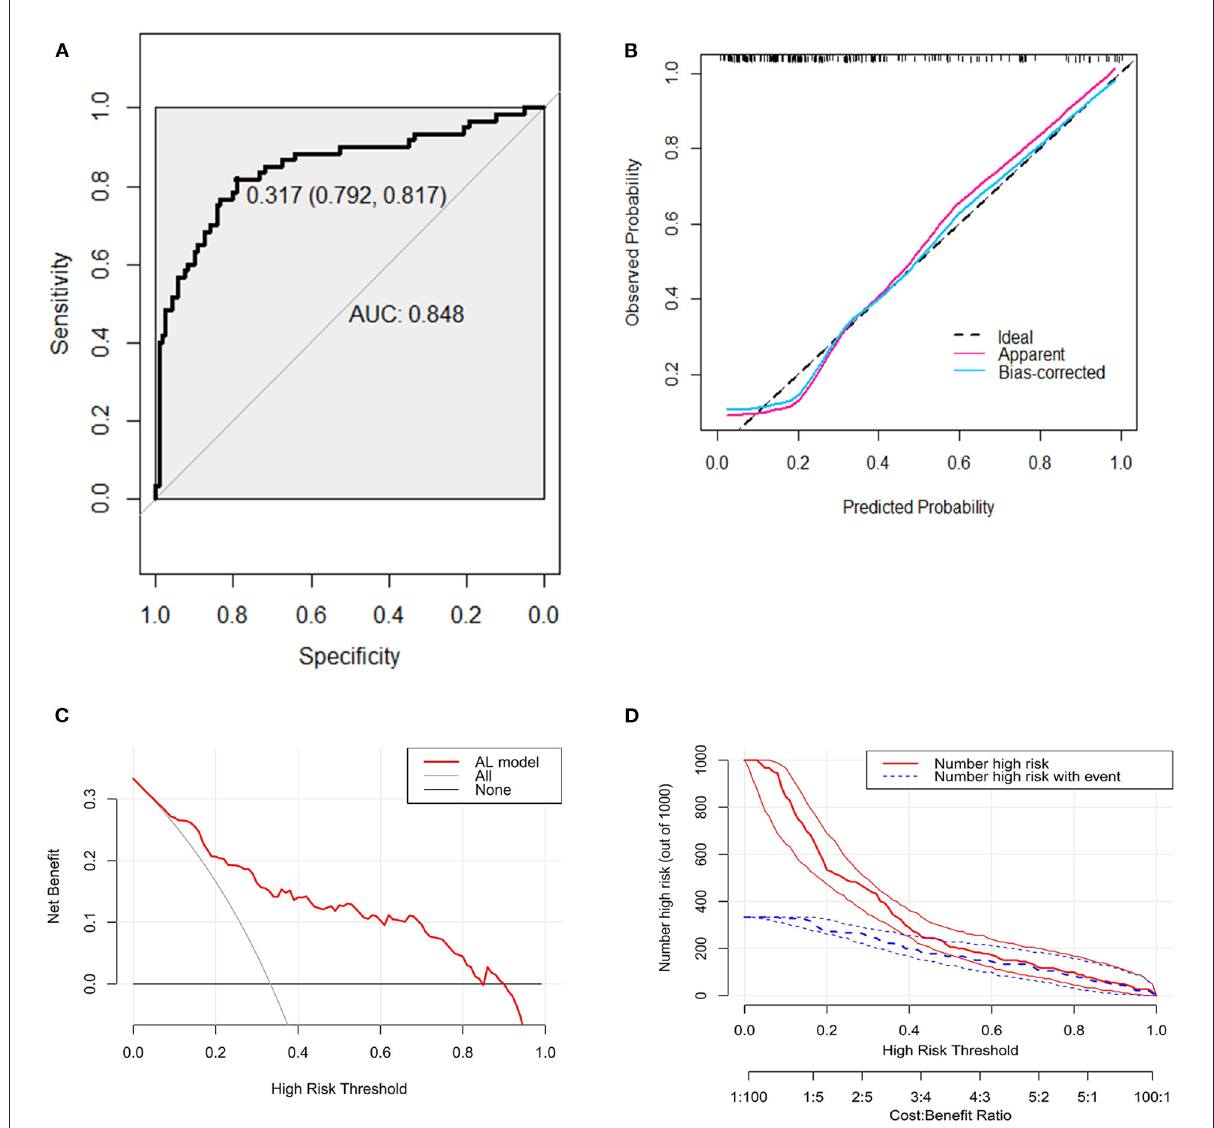
FIGURE3 Receiver operating characteristic curve, calibration curve, decision curve analysis (DCA), and clinical impact curve for predicting anastomotic leakage (AL) in patients with colorectal cancer (CRC). (A) Area under the curve for predicting the AL of patients with CRC. (B) Calibration plot of the prediction model (bootstrap method, 1,000 repetitions). (C) Decision curve analysis of the model for predicting the risk of AL for patients with CRC. The x-axis means the threshold probability and the y-axis means the net benefit. The black line assumes that no patient has AL. The gray line assumes that all patient has AL. (D) Clinical impact curve. The red curve (Number high risk) represents the number of people classified as positive (high risk) by the model at each threshold probability; the blue curve (Number high risk with event) is the number of true positives under each threshold